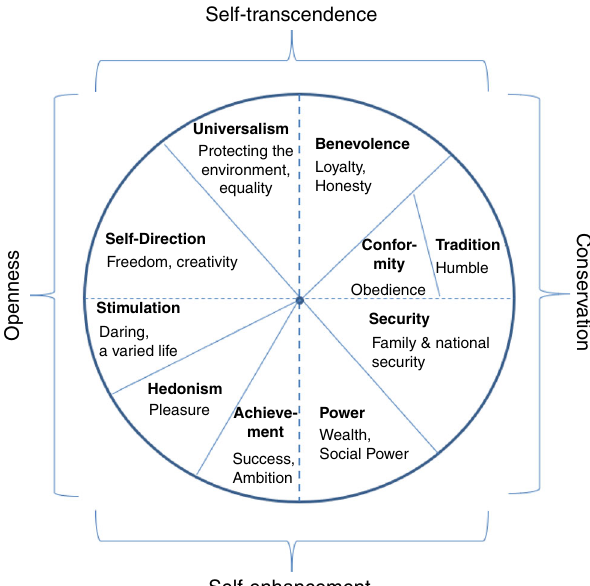
Fig. 1 Model of human values. Schwartz ’ 8 quasi-circumplex model of human values displaying four higher value types, ten value types (bold font), and examples of values in each type (normal font; adapted from ref. 75